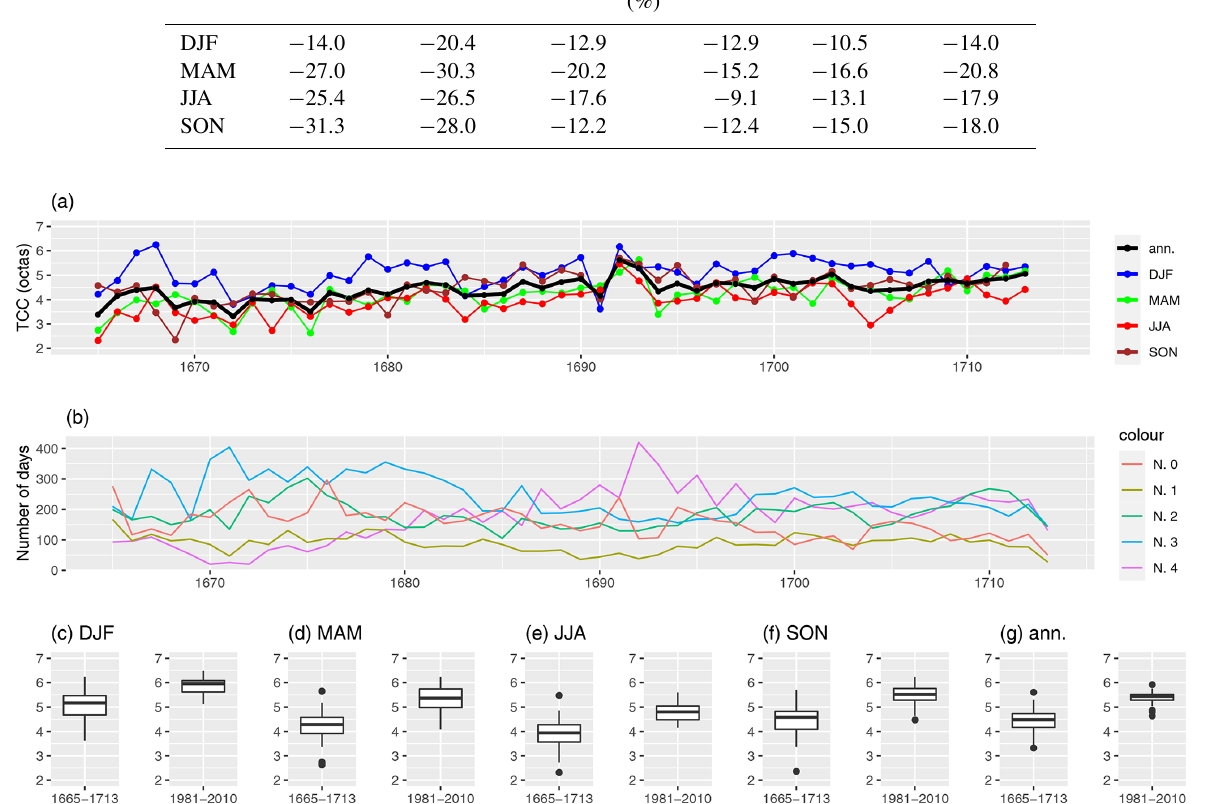
Figure 8. Total cloud cover (TCC) in oktas from Louis Morin’s readings is shown in panel (a) : yearly means of DJF, MAM, JJA, SON, and the whole year. In panel (b) the different notes (0 to 4) are shown on a timeline. The box plots show the seasonal and annual means of the time period of Morin’s measurements and the mean of the data from ERA5 for 1981–2010 (c–g) .